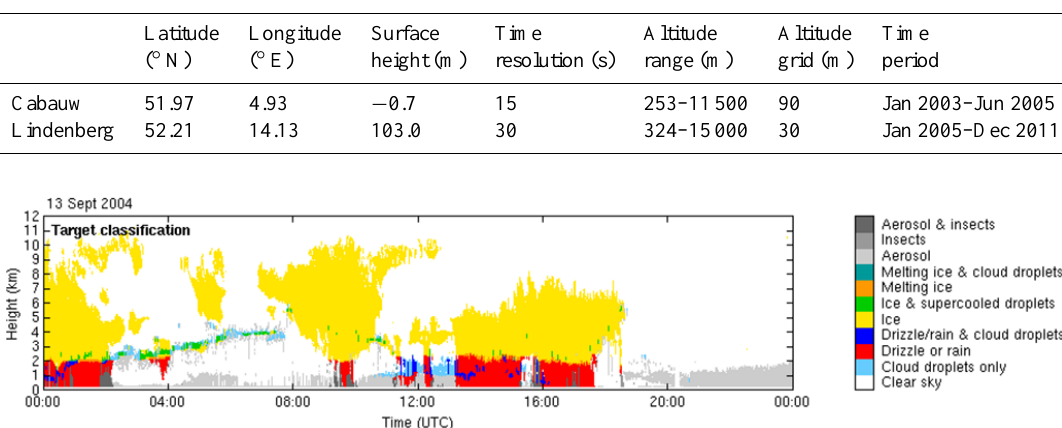
Figure 1. Quick-look image of the Cloudnet target classification product at Lindenberg on 13 September 2004 (downloaded from www.